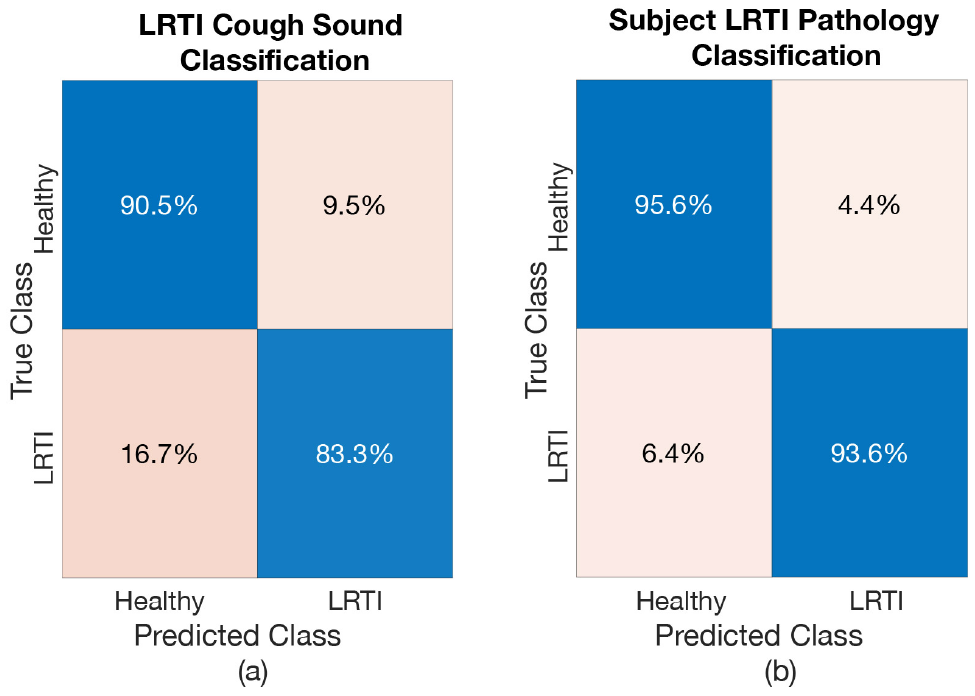
Figure 8. Confusion Matrix of Healthy vs. LRTI Model : ( a ) when classifying LRTI coughs, ( b ) when classifying subject for LRTI.